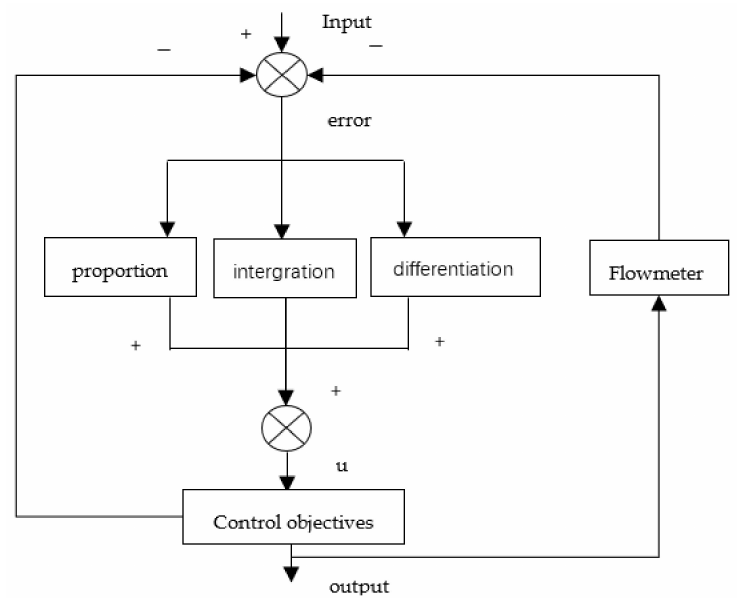
Figure 4. PID dominant method block